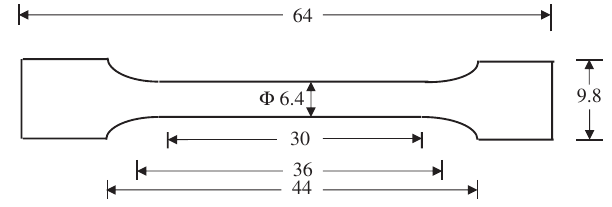
Figure 6: Tensile test specimen (all dimensions in